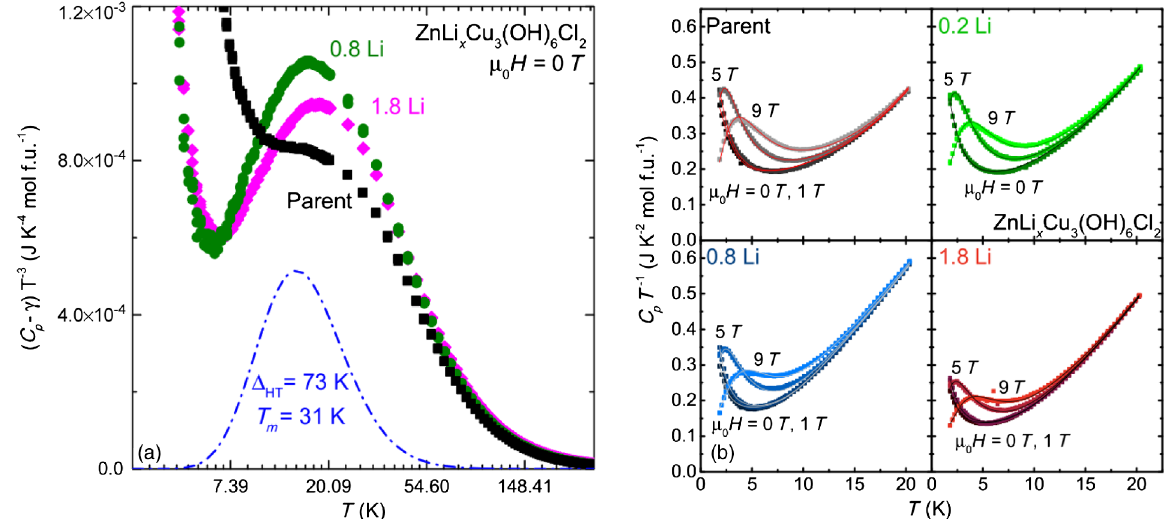
FIG. 5. Detailed heat capacity analysis of ZnLi x Cu 3 ð OH Þ 6 Cl 2 series. (a) High-temperature ( C p − γ ) T − 3 Schottky analysis of the temperature range T ¼ 1 . 8 – 300 K for the parent ZnCu 3 ð OH Þ 6 Cl 2 (black), ZnLi 0 Cu 3 ð OH Þ 6 Cl 2 (dark green), and ZnLi 0 Cu 3 ð OH Þ 6 Cl 2 . 8 . 8 (magenta). The dashed blue line is the high-temperature Schottky anomaly of the extracted values from the zero-field T ¼ 1 . 8 – 20 K fits. It does a good job of describing the Schottky anomaly we see in the doped samples in the higher-temperature region of the heat capacity. Debye modes (which are a constant at low temperature and fall off at higher temperatures) are not shown for clarity. (b) Simple model fits to field-dependent heat capacity measurements. Top left: the parent ZnCu 3 ð OH Þ 6 Cl 2 (black); top right: ZnLi 0 Cu 3 ð OH Þ 6 Cl 2 . 2 (green); bottom left: ZnLi 0 Cu 3 ð OH Þ 6 Cl 2 (blue); bottom right: ZnLi 1 Cu 3 ð OH Þ 6 Cl 2 (red). The data sets go from a dark color at low . 8 . 2 fields to a lighter color at higher fields. The lines are fits as described in the